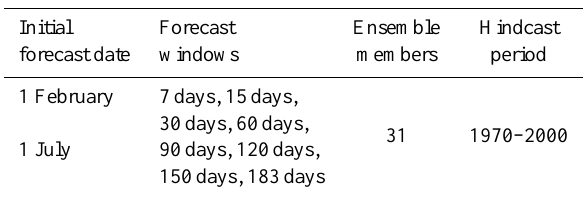
Table 2. Details of the experiment designs (for different forecast